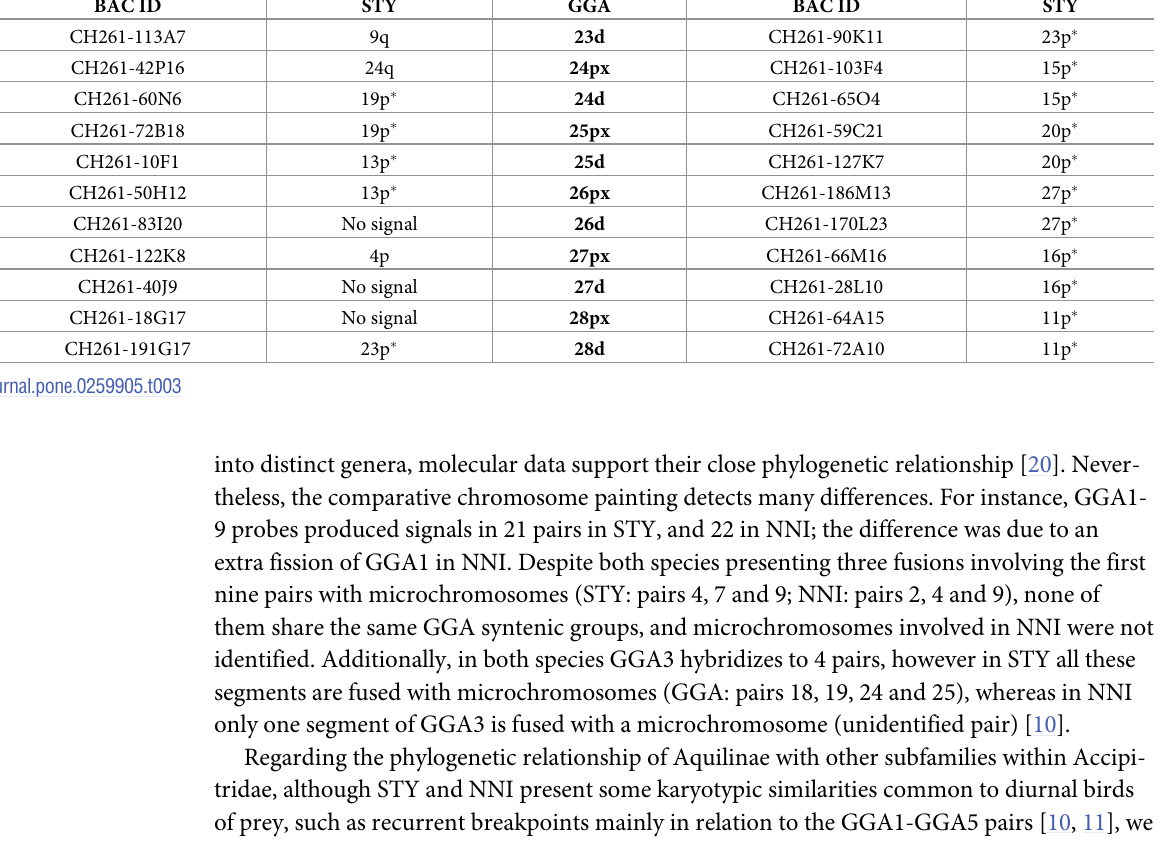
Table 3. Summary of the results of experiments using GGA BACs on the karyotype of S . tyrannus ( � = BACs marking the same segment in STY karyotype; px = proximal region; d = distal region; p = short arm; q = long arm). GGA BAC ID STY GGA BAC ID